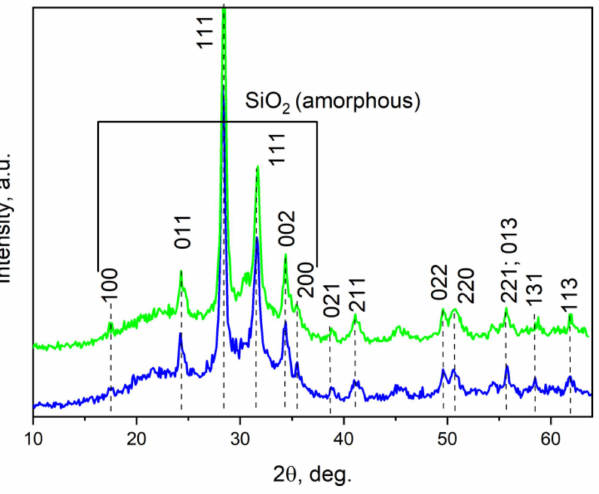
Figure 6. XRD patterns of HfO 2 /SiO 2 coatings after exposure to UV/VUV radiation in neon (green) and air